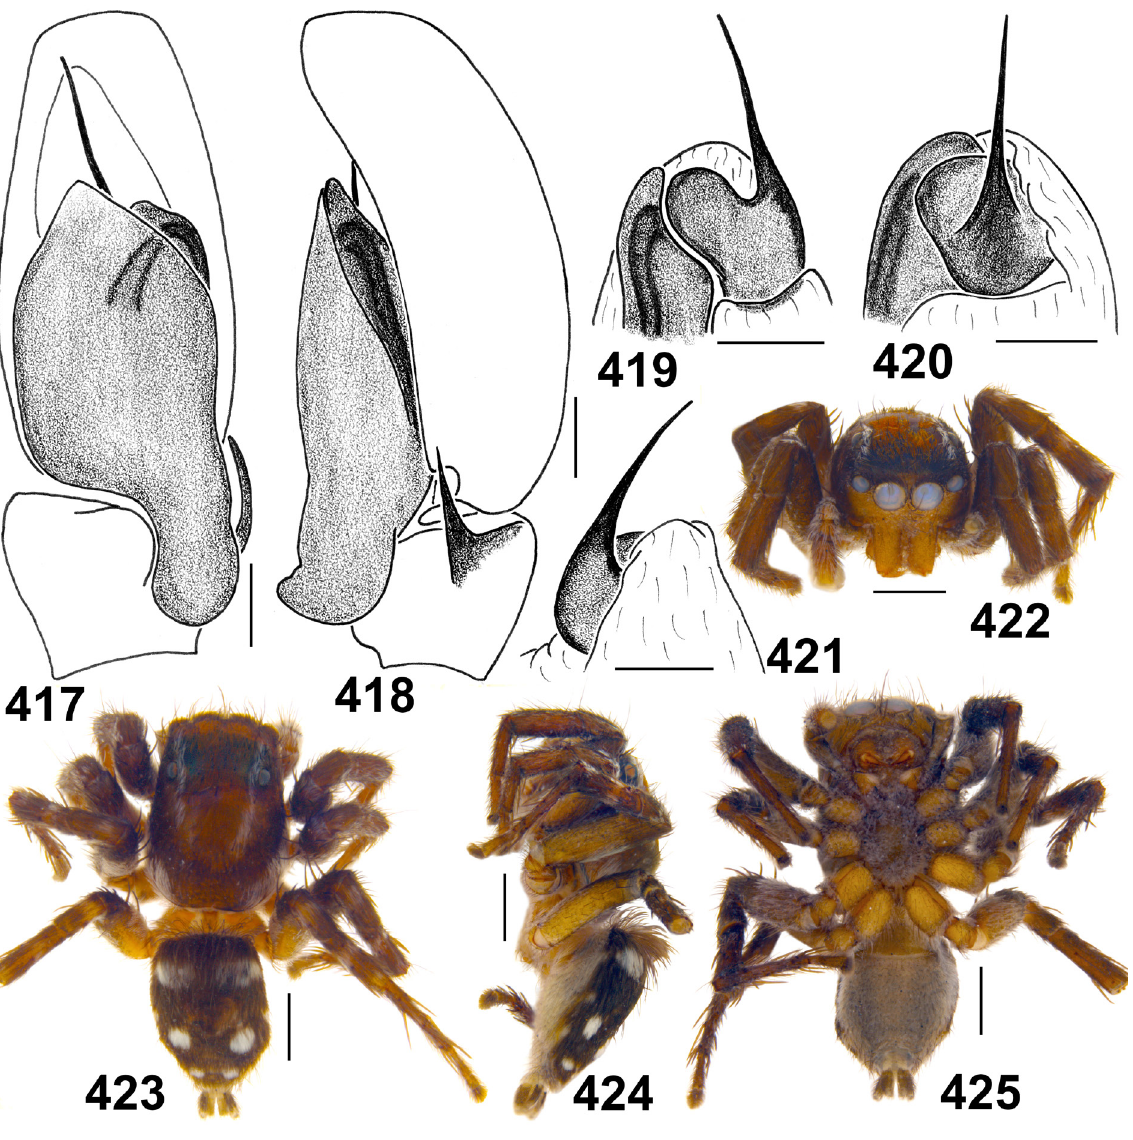
Figs 417–42 5 . Stenaelurillus pseudoguttatus sp. nov., paratype, ♂, of Mashonarus guttatus Wesołowska & Cumming, 2002; MRAC 152.151). 417 . Male palp, ventral view. 418 . Male palp, retrolateral view. 419–421 . Embolic division. 419 . Retrolateral view. 420 . Dorsal view. 421 . Median view. 422–425 . General appearance. Scale bars: 417–421 = 0.1 mm; 422–425 = 1